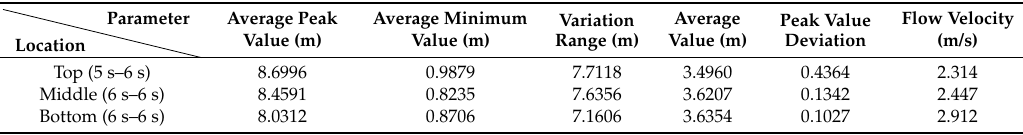
Table 8. Flushing results by setting rectangular nozzle at different locations.